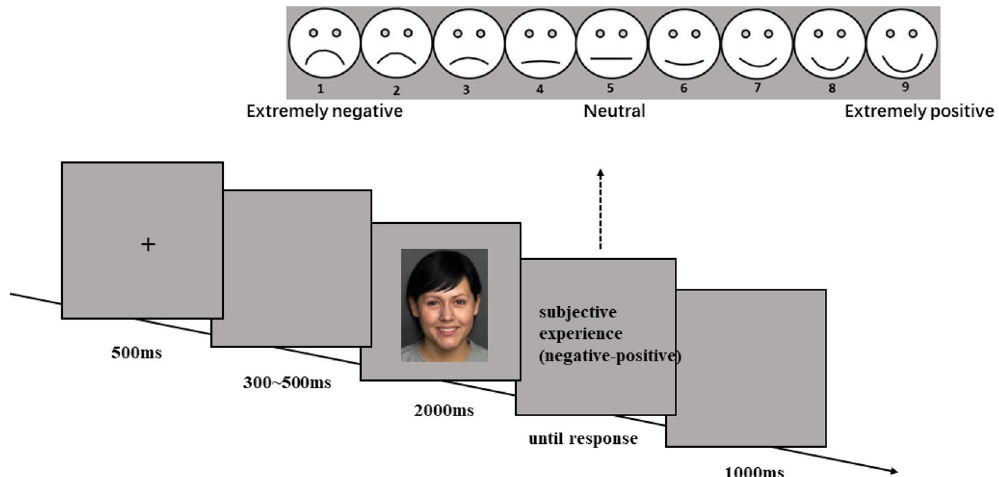
Figure 2. Experimental procedure of Experiment 1. The emotional expression video clips (No. 140) was selected from the dynamic FACES database 42 , and have been permitted to use by its